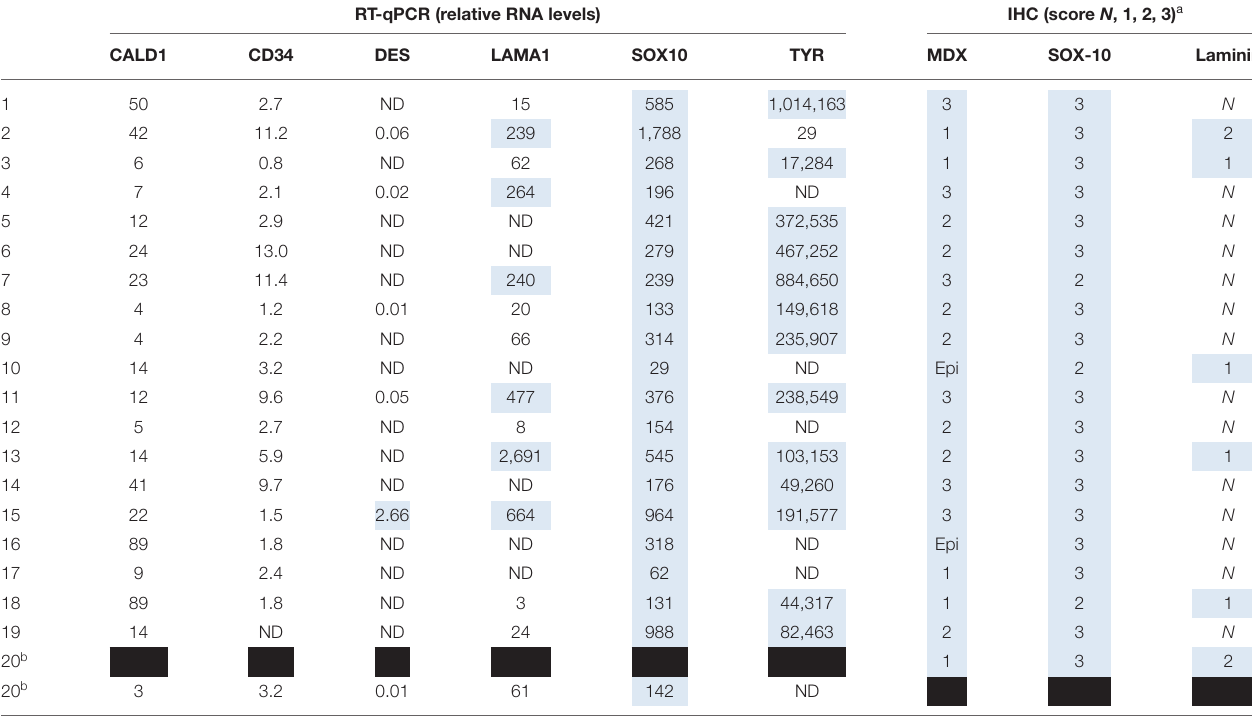
Gray background, RNA expression above cutoff or positive immunohistochemical labeling; ND, not detected; Epi, positive labeling was exclusively within the mucosal epithelium and thus precluded scoring. a Percentages of positive cells were assigned a score of N ( ≤ 10% positive labeling of neoplastic cells), 1 (11–50%), 2 (51–80%), or 3 (81–100%). b Tissue in paraffin block was depleted, and another block from the same tumor was used for